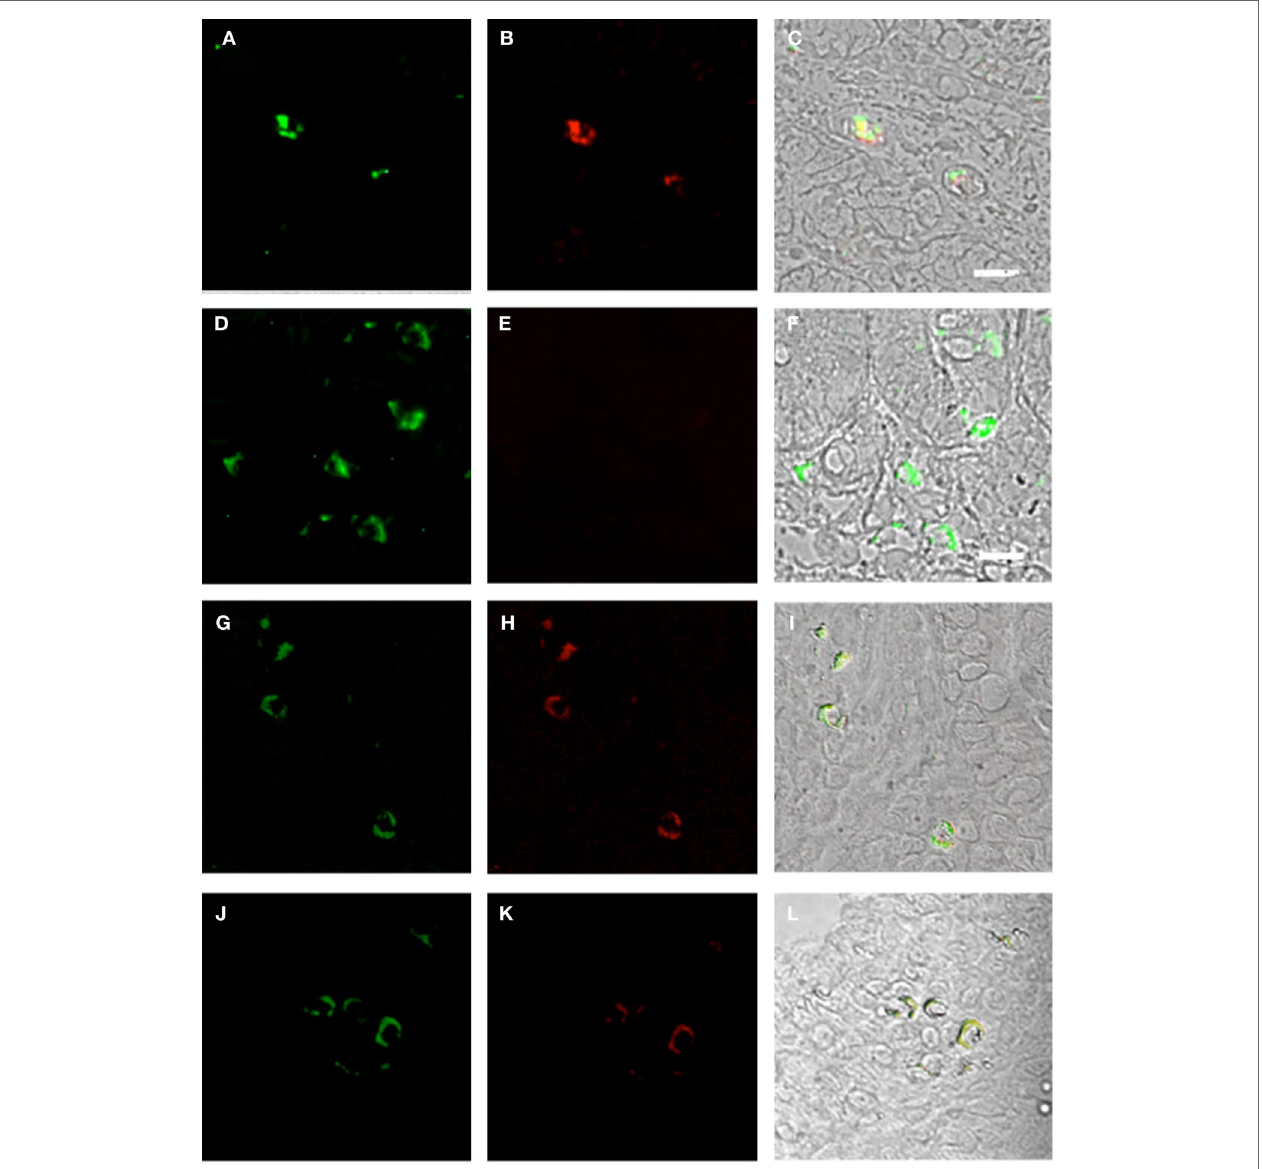
FigUre 4 | Duodenum biopsies of hiV/aiDs cases and controls evaluated for coexpression of cD303 (green) and cD123 (red) and for cD303 (green) and cD80 (red) . Bar represents 20 μ m. (a) Control duodenum biopsies probed with a monoclonal FITC-anti-CD303 antibody. (B) Control duodenum biopsies probed with a monoclonal PE-anti-CD123 antibody. (c) Control duodenum biopsies DIC image merged with (a,B) . (D) HIV case duodenum biopsies probed with a monoclonal FITC-anti-CD303 antibody. (e) HIV case duodenum biopsies probed with a monoclonal PE-anti-CD123 antibody. (F) HIV case duodenum biopsies DIC image merged with (D , e) . (g) Control duodenum biopsies probed with a monoclonal FITC-anti-CD303 antibody. (h) Control duodenum biopsies probed with a monoclonal PE-anti-CD80 antibody. (i) Control duodenum biopsies DIC image merged with (g,h) . (J) HIV case duodenum biopsies probed with a monoclonal FITC-anti-CD303 antibody. (K) HIV case duodenum biopsies probed with a monoclonal PE-anti-CD80 antibody. (l) HIV case duodenum biopsies DIC image merged with (J,K)